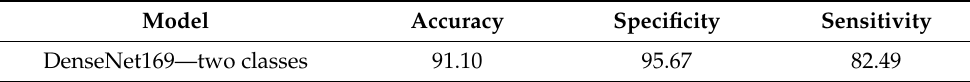
Table 5. Metrics for the two-class DenseNet169 mapping